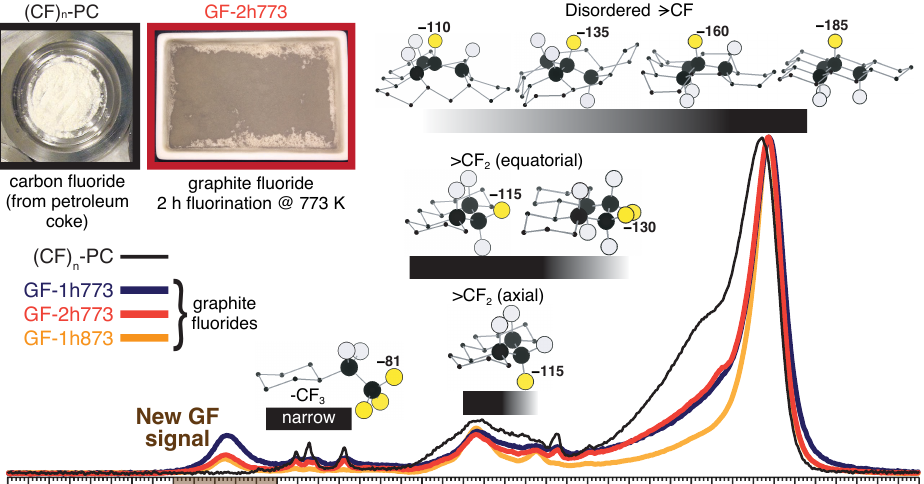
Figure 1. Solid-state 19 F centerband MAS NMR spectra of commercial poly(carbon monofluoride) made from petroleum coke ((CF) n -PC) and the three graphite fluorides (GF) synthesized for this work. The new graphite fluoride NMR signal is indicated near − 53 ppm by the brown axis shading. Grayscale bars near the molecular models indicate approximate chemical shift ranges for the fluorine atoms depicted in yellow of the associated models; these atoms are also numerically labeled by a representative 19 F chemical shift value. Black atoms, C; bluish-white atoms, other F. Chemical shifts represented by faded parts of the bar are achieved only in cases of extreme chemical